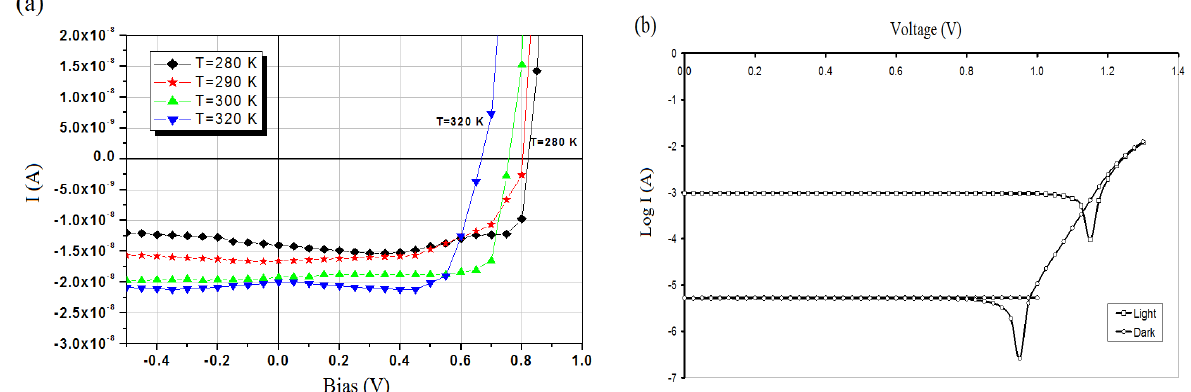
Figure 13. ( a ) Linear-linear I-V curves at different temperatures under complete darkness and ( b ) log (I)-V curves measured under dark and AM1.5 illuminated conditions. Note the production of V oc values above ~950 mV in complete dark conditions indicates the presence of impurity PV